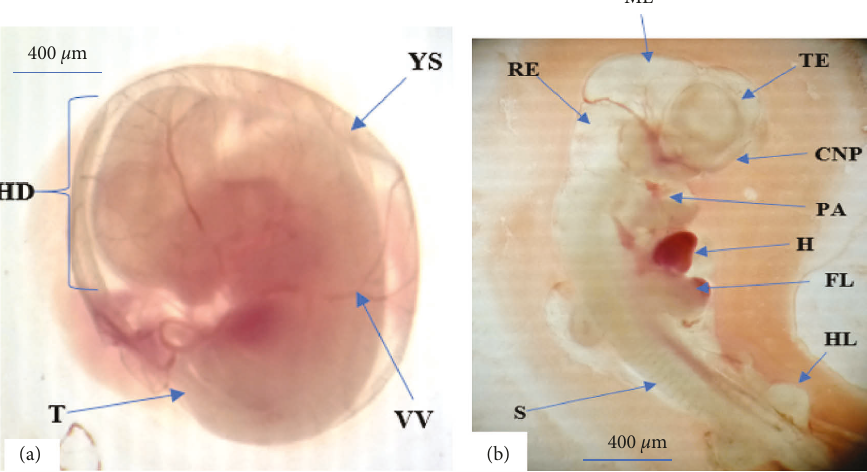
Figure 1: 12 days old embryos from rats treated with 1000mg/kg crude extract of E. schimperi . (a): Embryo enclosed by its yolk sac (YS) with visible vitelline vessels (VV), distinguishable head (HD), and tail (T) regions. (b): CNP (cranial neuropores/closed), FL (fore limb), HL (hind limb), ME (mesencephalon), PA (pharyngeal apparatus), RE (rhombencephalon), S (somite), and TE